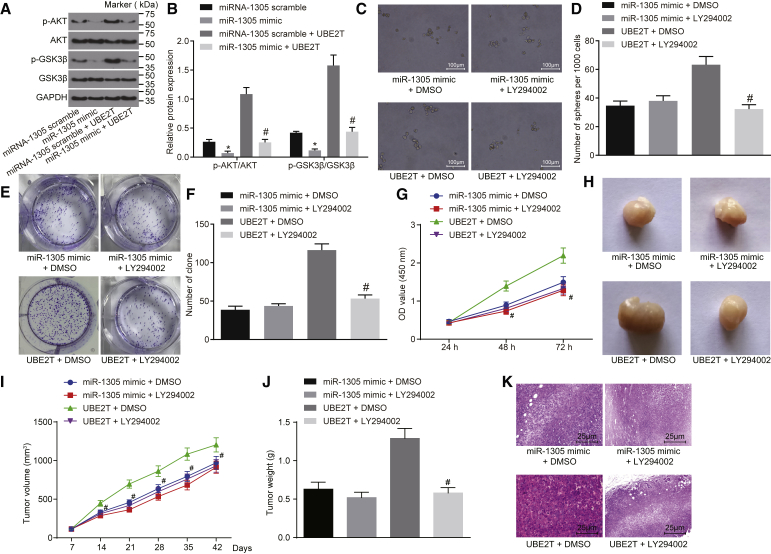
Self-Renewal and Tumorigenic Potential of LCSCs Were Repressed by miR-1305 through the UBE2T-Mediated Akt-Signaling Pathway(A) The gray value of Akt and GSK3β and their phosphorylation protein bands in LCSCs measured by western blot analysis. (B) The protein expressions of Akt and GSK3β and the extents of their phosphorylation in LCSCs, measured by western blot analysis. (C) The sphere formation assay in LCSCs treated with DMSO or LY294002 in the presence of miR-1305 mimic or UBE2T over-expression (100×). (D) The quantitative analysis of sphere formation ability in (C). (E) The soft agar colony formation assay in LCSCs treated with DMSO or LY294002 in the presence of miR-1305 mimic or UBE2T over-expression. (F) The quantitative analysis of soft agar colony formation in (E). (G) The proliferative ability of LCSCs that overexpressed miR-1305 or UBE2T and were treated with DMSO or LY294002, evaluated by CCK-8 assay. (H) Naked eye observation of tumor in nude mice treated with DMSO or LY294002 in the presence of miR-1305 mimic or UBE2T overexpression. (I) The tumor volume curve in nude mice treated with DMSO or LY294002 in the presence of miR-1305 mimic or UBE2T overexpression, measured by a Vernier caliper. (J) The tumor weight in nude mice in the presence of miR-1305 mimic or UBE2T overexpression with DMSO or LY294002 treatment. (K) The pathological characteristics of tumor in nude mice injected with miR-1305 mimic or UBE2T overexpression with DMSO or LY294002 treatment, observed with H&E staining (400×). miR-1305 scramble + DMSO group, LCSCs or nude mice transfected with miR-1305 mimic, then treated with DMSO; miR-1305 mimic + LY294002 group, LCSCs or nude mice transfected with miR-1305 mimic, then treated with LY294002; UBE2T + DMSO group, LCSCs or nude mice transfected with UBE2T overexpression, then treated with DMSO; UBE2T + LY294002 group, LCSCs or nude mice transfected with UBE2T overexpression, then treated with LY294002. *p < 0.05 versus LCSCs or nude mice transfected with miR-1305 mimic, then treated with DMSO; #p < 0.05 versus LCSCs or nude mice transfected with UBE2T overexpression, then treated with DMSO. Statistical data were described as mean ± SD. Data were analyzed by one-way ANOVA, and data in (G) and (I) were compared by repeated-measures ANOVA. The experiment was repeated 3 times independently (n = 6).